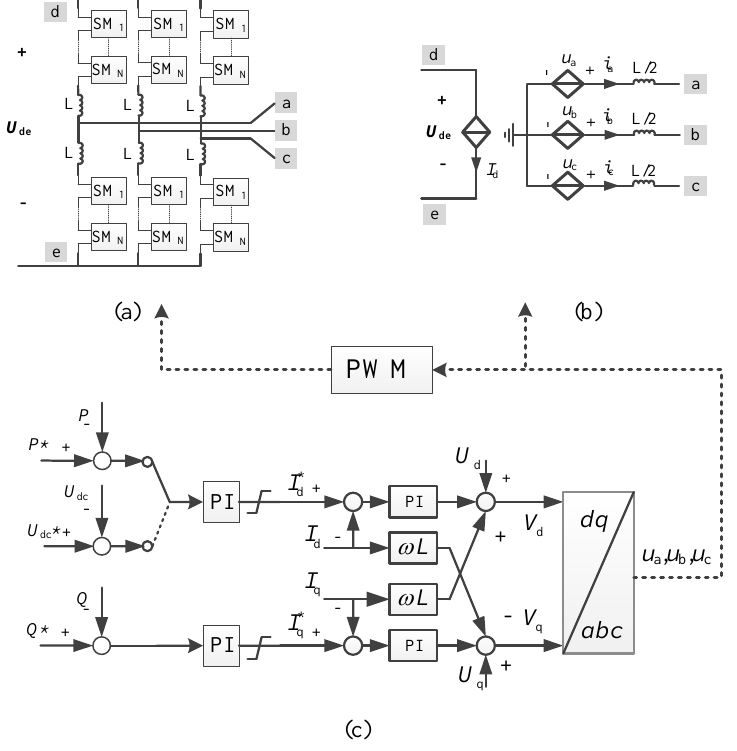
Figure 6. ( a ) DC/Alternating Current (AC) topology; ( b ) Average model of DC/AC; and, ( c ) Controller design of DC/AC converter.